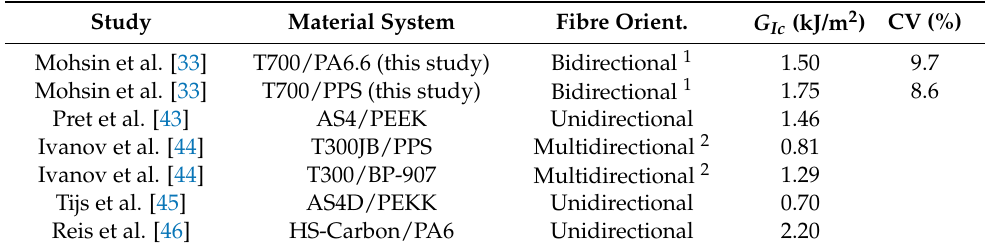
Figure 7. Representative R-curve (specimen #1 T700/PA6.6) against measured crack length. Based on the R-curves obtained for both specimens, the Mode I fracture toughness, G Ic , for both samples, was calculated and tabulated as shown in Table 3. The average G Ic calculated for the T700/PA6.6 and T700/PPS were 1.50 kJ/m 2 (CV = 9.7%) and 1.75 kJ/m 2 (CV = 8.6%), respectively. These results demonstrate that the Mode I interlaminar fracture toughness of the T700/PPS is approximately 17% higher than the T700/PA6.6 system. Table 3. Summary of the Mode I interlaminar fracture toughness of T700/PA6.6 and T700/PPS.